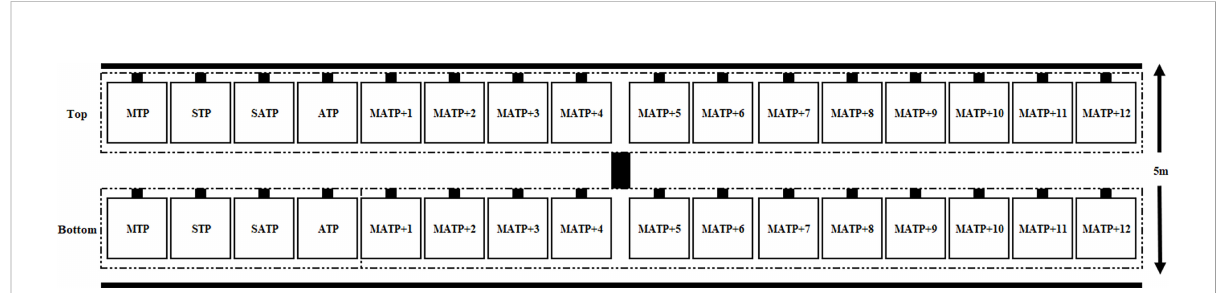
FIGURE 3 Deployment schematic diagram of the test panels installation. MTP, monthly test panel; STP, seasonal test panel; SATP, semi-annual test panel; ATP, annual test panel; MATP, monthly accumulation test